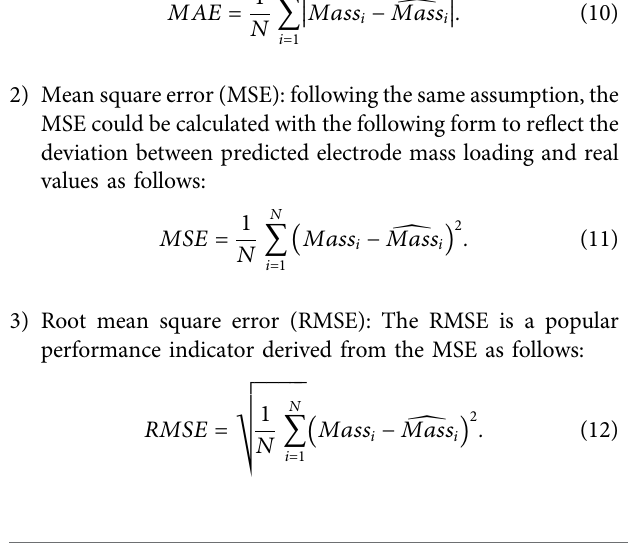
Frontiers in Energy Research |